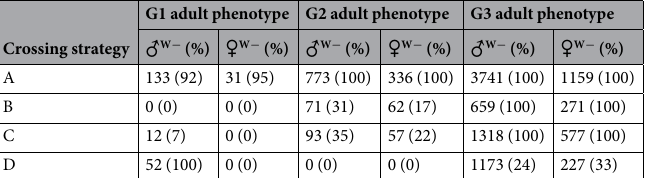
Table 3. Summary of G1, G2 and G3 phenotypes of N . vitripennis with different crossing strategies. For cross strategy A, G0 mutant ♂ X G0 mutant ♀ , G1 mutant ♂ X G1 mutant ♀ , G2 mutant ♂ X G2 mutant ♀ .